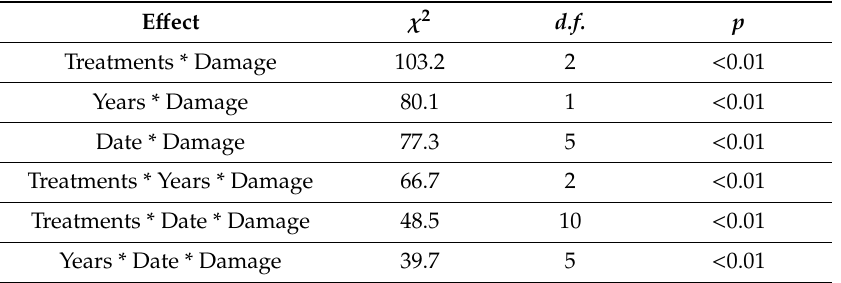
Table 4. Log linear analysis of fruit damage. Only the interaction of response variable (fruit damage) with design variables (treatments–years–plots–sampling dates) are considered in the analysis. E ff